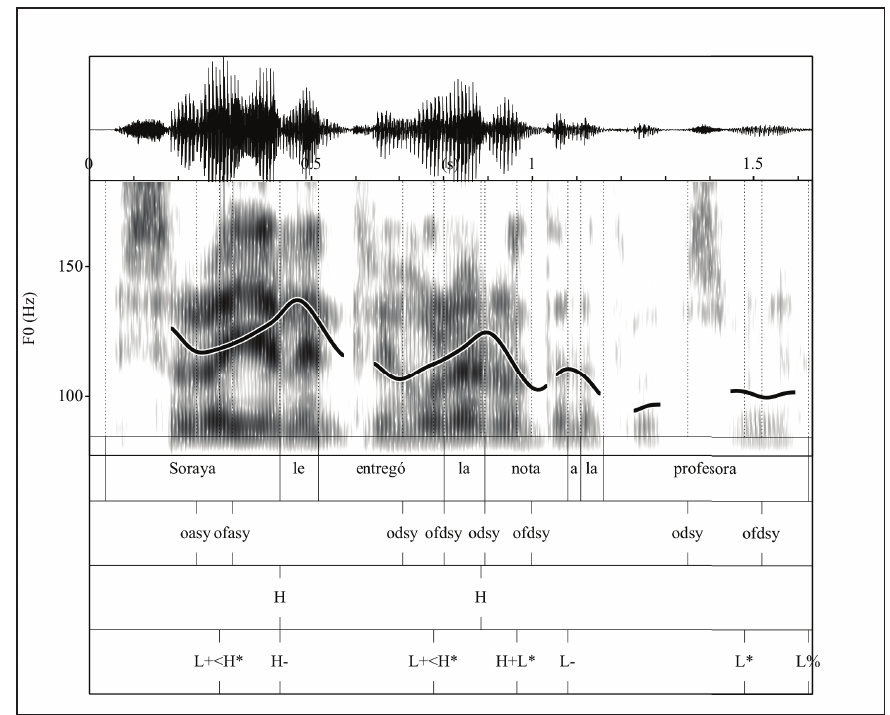
Figure 5: The utterance Soraya le entregó la nota a la profesora ‘Soraya gave the note to the teacher’ as produced by participant